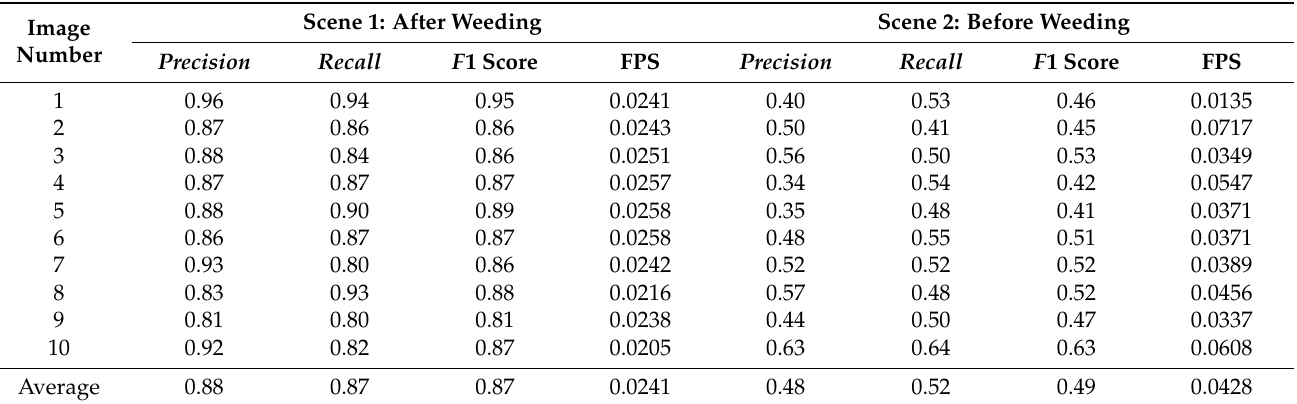
Table 3. Statistics of citrus tree detection results based on Hough transform.